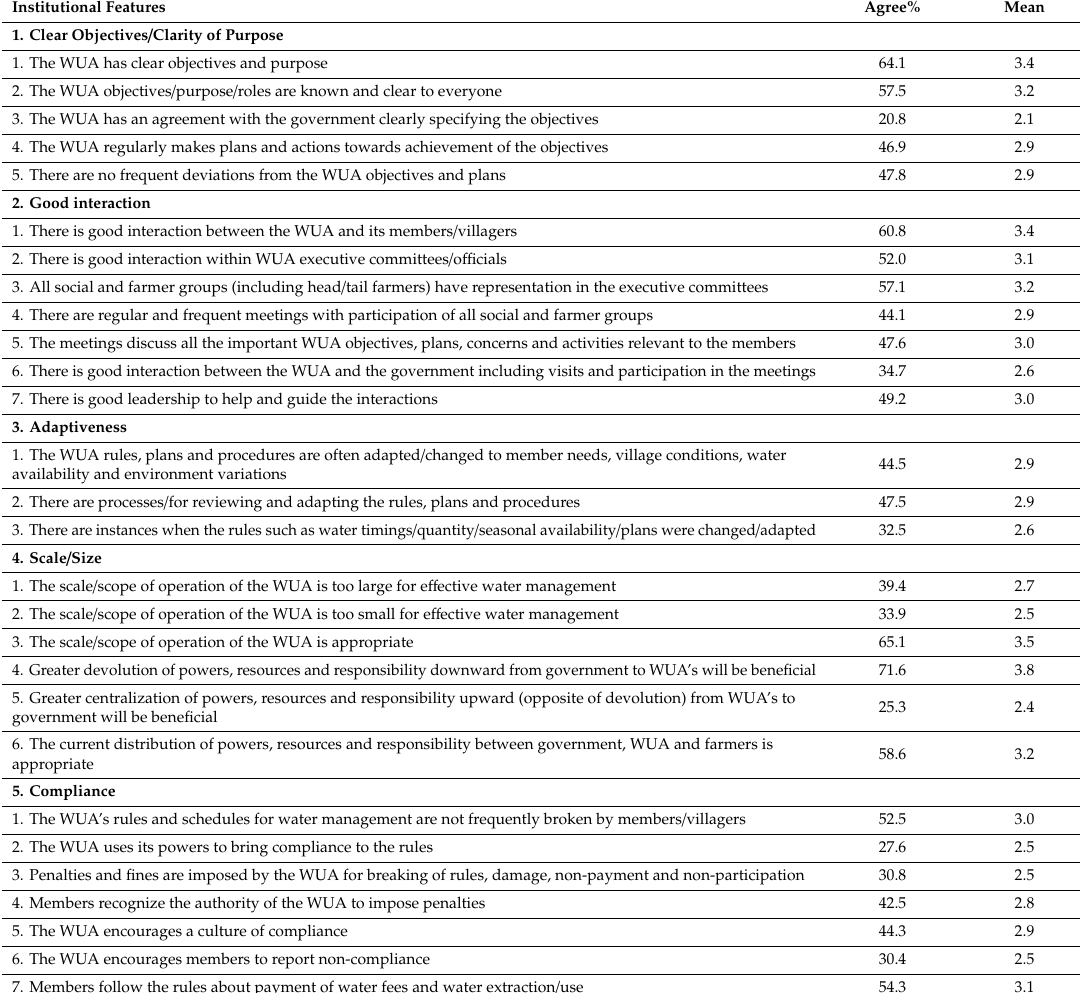
Table 8. Assessment on Institutional Features–Percent